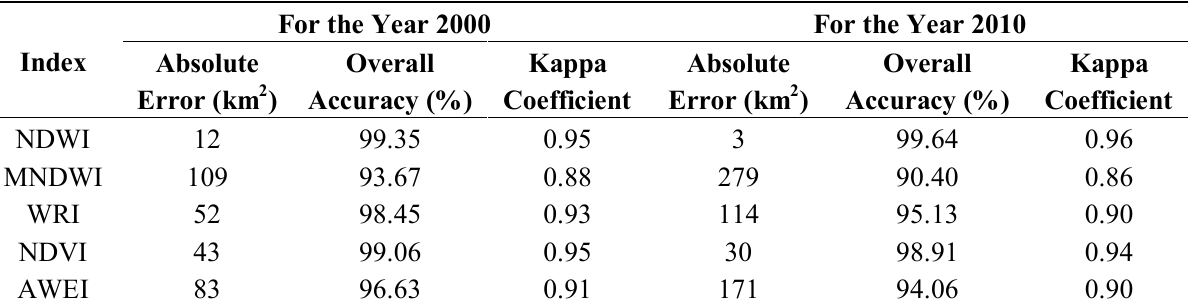
Table 4. Accuracy assessment